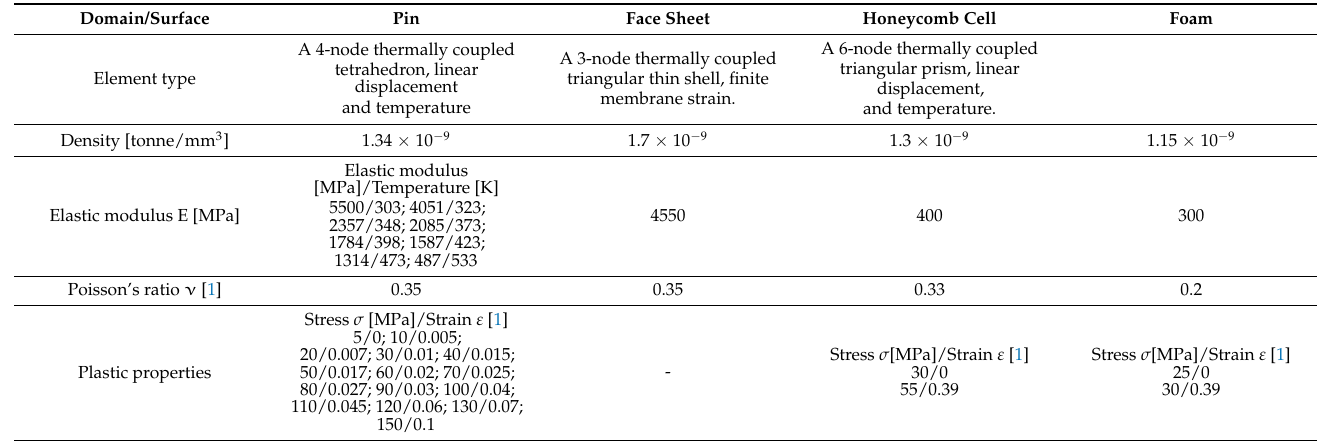
Table A1. FEM material definitions and contact